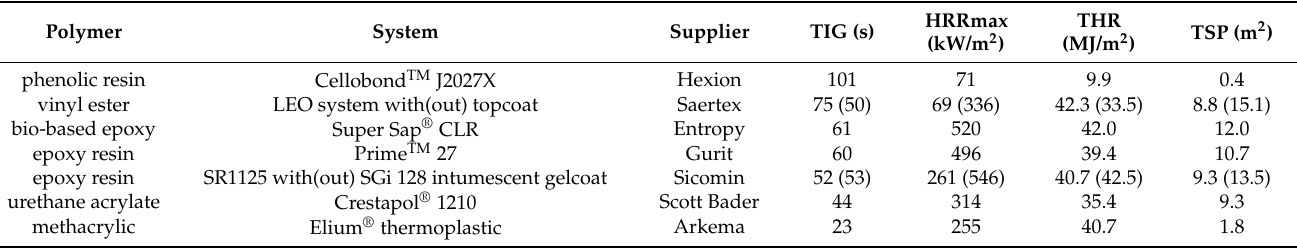
Table 3. Fire performance of the FIBRESHIP composite laminates ranked by decreasing time to ignition (TIG)